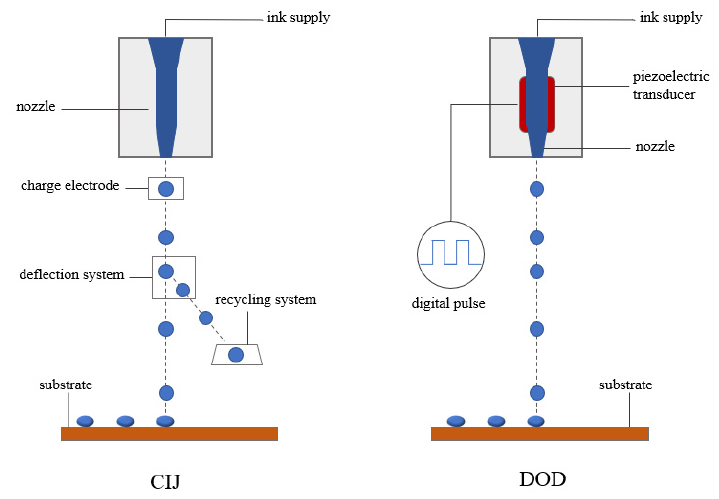
Figure 9. Schematic diagram of inkjet printing [74] .